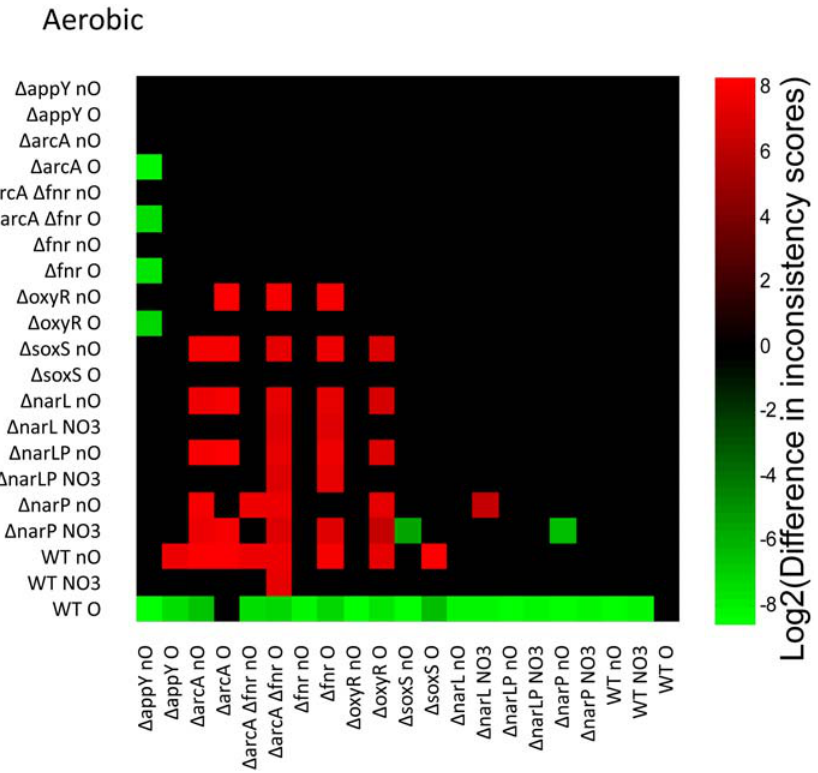
Figure 6. Pairwise comparisons of consistency for aerobic conditions. A graphical representation of the log2 transform of the difference between inconsistency scores. A green box indicates that the sample on the y -axis is more consistent with aerobic growth than the sample on the x - axis. Red boxes indicate the opposite. Differences that do not meet p , 0.05 are left blank. The shade of red or green quantifies the log2 of the difference in inconsistency scores. The position of green and red blocks here indicates that in all statistically significant cases, strains grown with oxygen have gene expression more consistent with efficient aerobic growth than strains grown without oxygen.